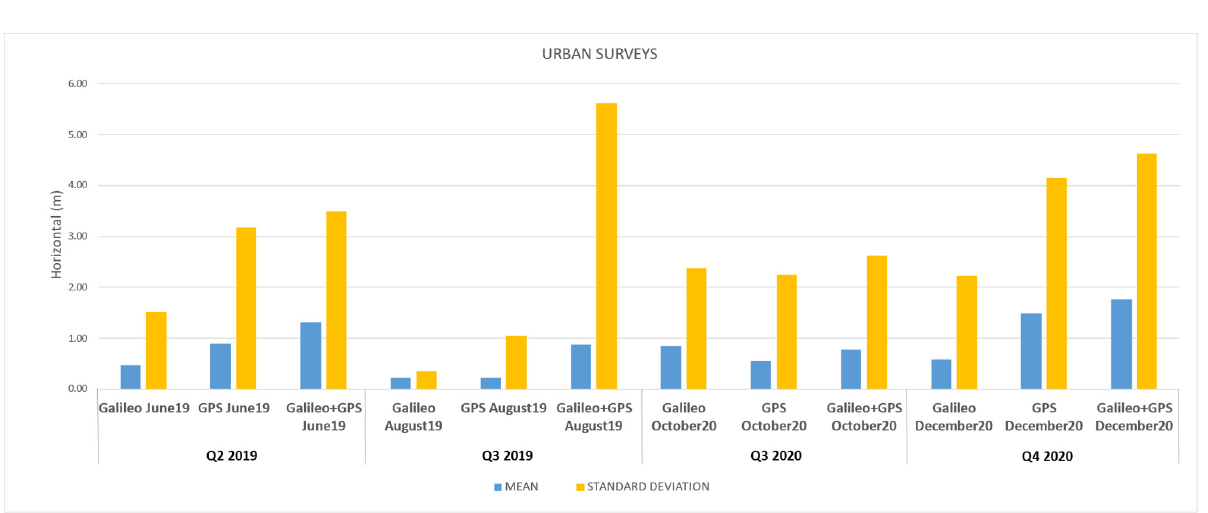
Table 9 indicates the maximum numbers of satellites available and the PDOP aver- ages for the Galileo-only, GPS-only, and Galileo+GPS constellations during each cam- paign (U: urban; E: extra-urban). Table 9. Average PDOP and maximum satellites number during the terrestrial data-collection cam- paigns.